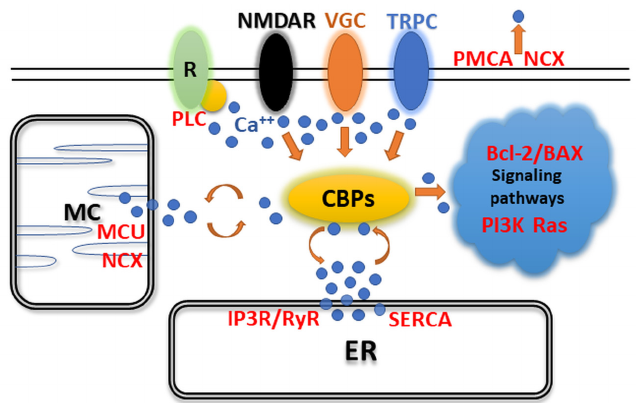
Figure 1. Signaling of EF-hand Ca 2+ -binding buffer proteins (CaBPs) shows a central role in Ca 2+ maintenance. Effects of G-protein-coupled phospholipase C (PLC), N-methyl-D-aspartate receptors (NMDARs), voltage-gated calcium channels (VGCs), and transient receptor potential cation channels (TRPCs) can be buffered by CaBPs. Intracellular Ca 2+ -dependent signal transduction is significantly controlled by CaBPs. This Ca 2+ originates from mitochondria (MC) and endoplasmic reticulum (ER). Mitochondrial calcium uniporter (MCU), inositol trisphosphate receptor, ryanodine receptor (IP3R/RyR), and sarco and endoplasmic reticulum Ca 2+ -ATPase (SERCA) control Ca 2+ levels intracellularly, while the sodium–calcium exchanger (NCX) can also be found on the MC and cell membranes. Plasma membrane Ca 2+ -ATPase (PMCA) and NCX are responsible for the removal of Ca 2+ from the cell.